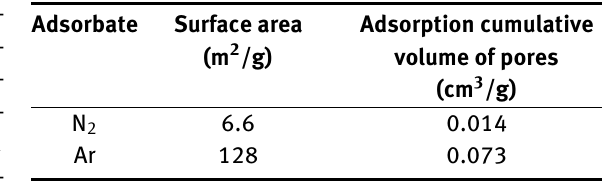
Table 1: Textural properties at − 195.8 ∘ C of as-synthesized LTA zeo- lite sample using N 2 and Ar as the